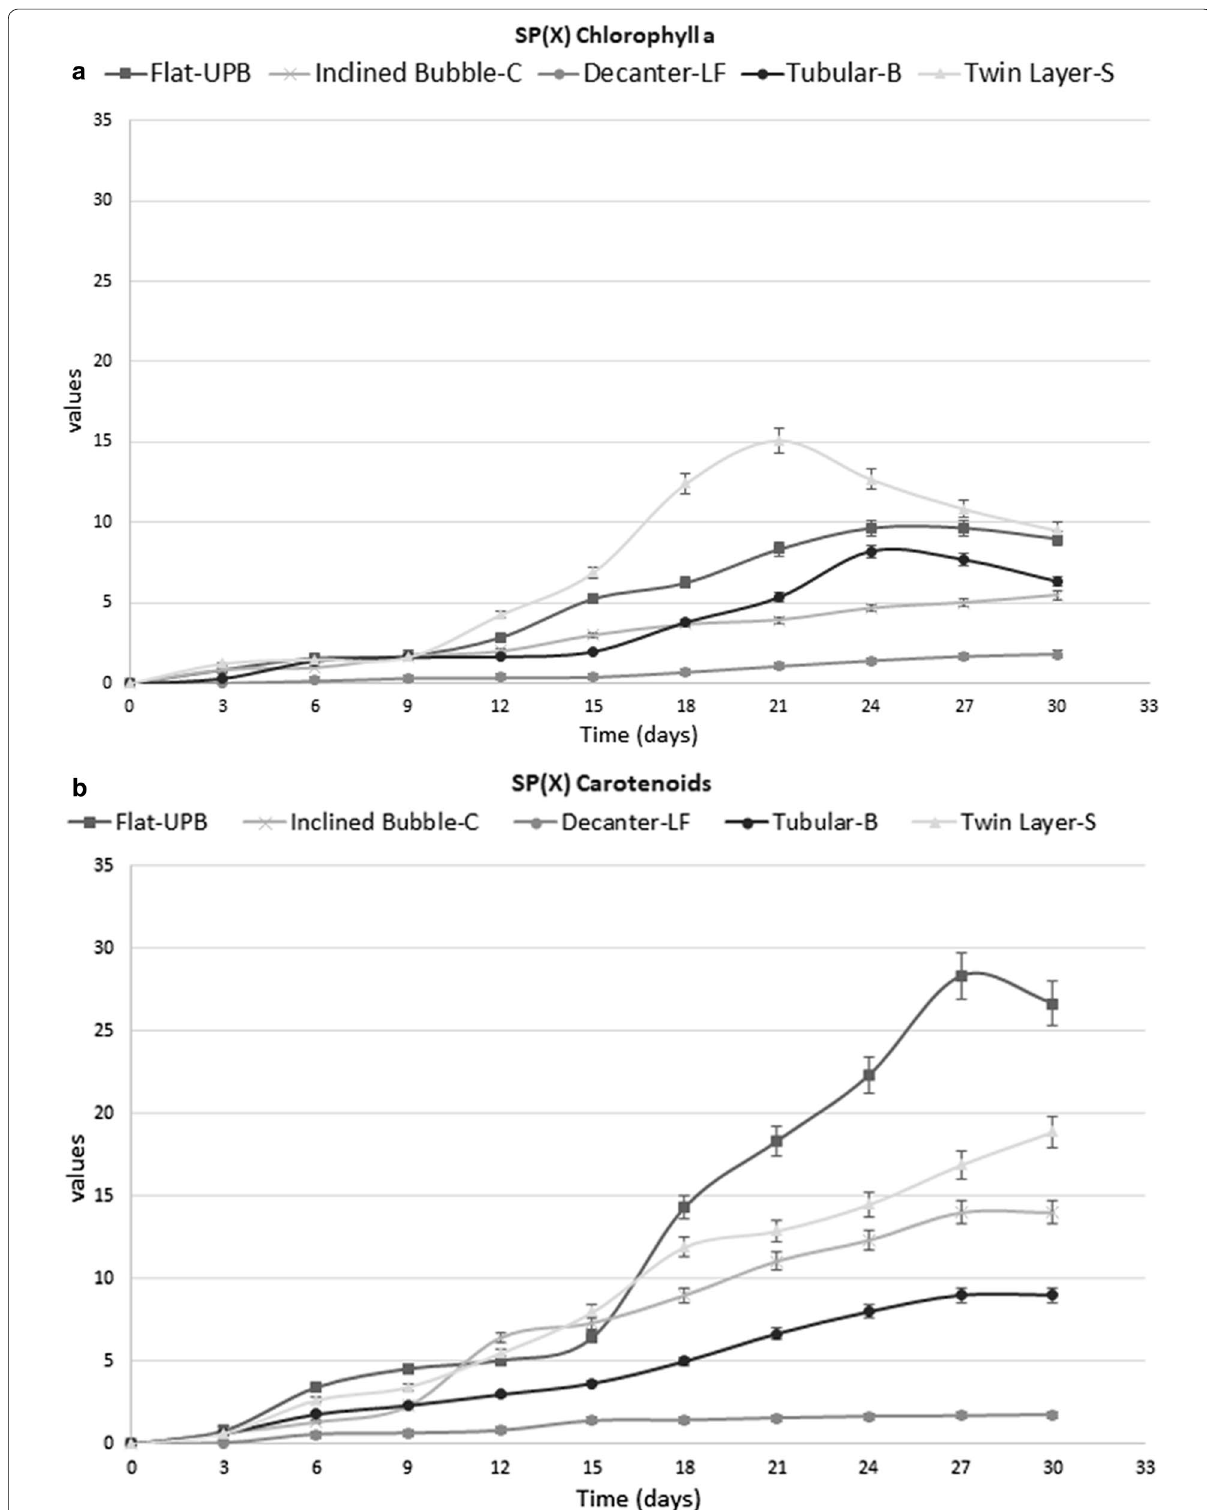
Fig. 4 a Specific chlorophyll a increase in different systems during the course of experiment. b Specific total carotenoids increase in different systems during the course of